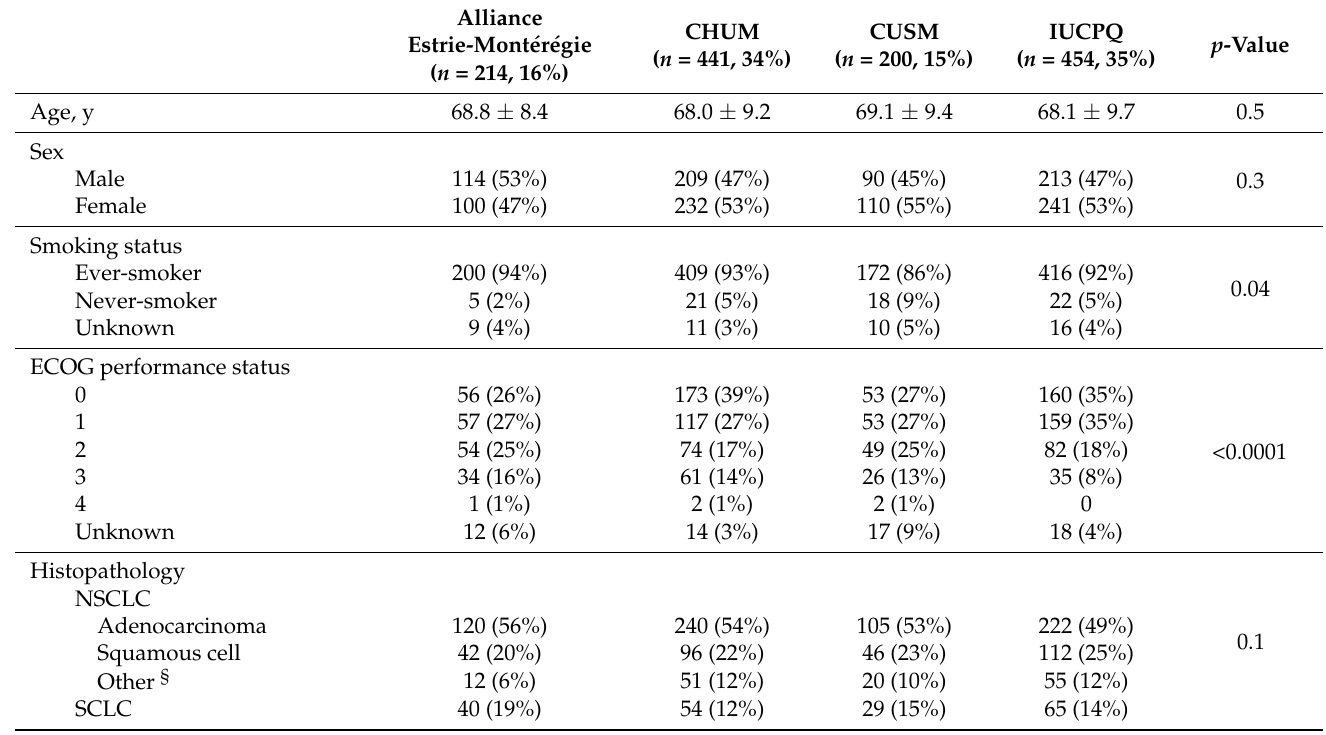
Figure 2. Flow chart of patient selection. Table 1. Patient characteristics by hospital network (n = 1309).